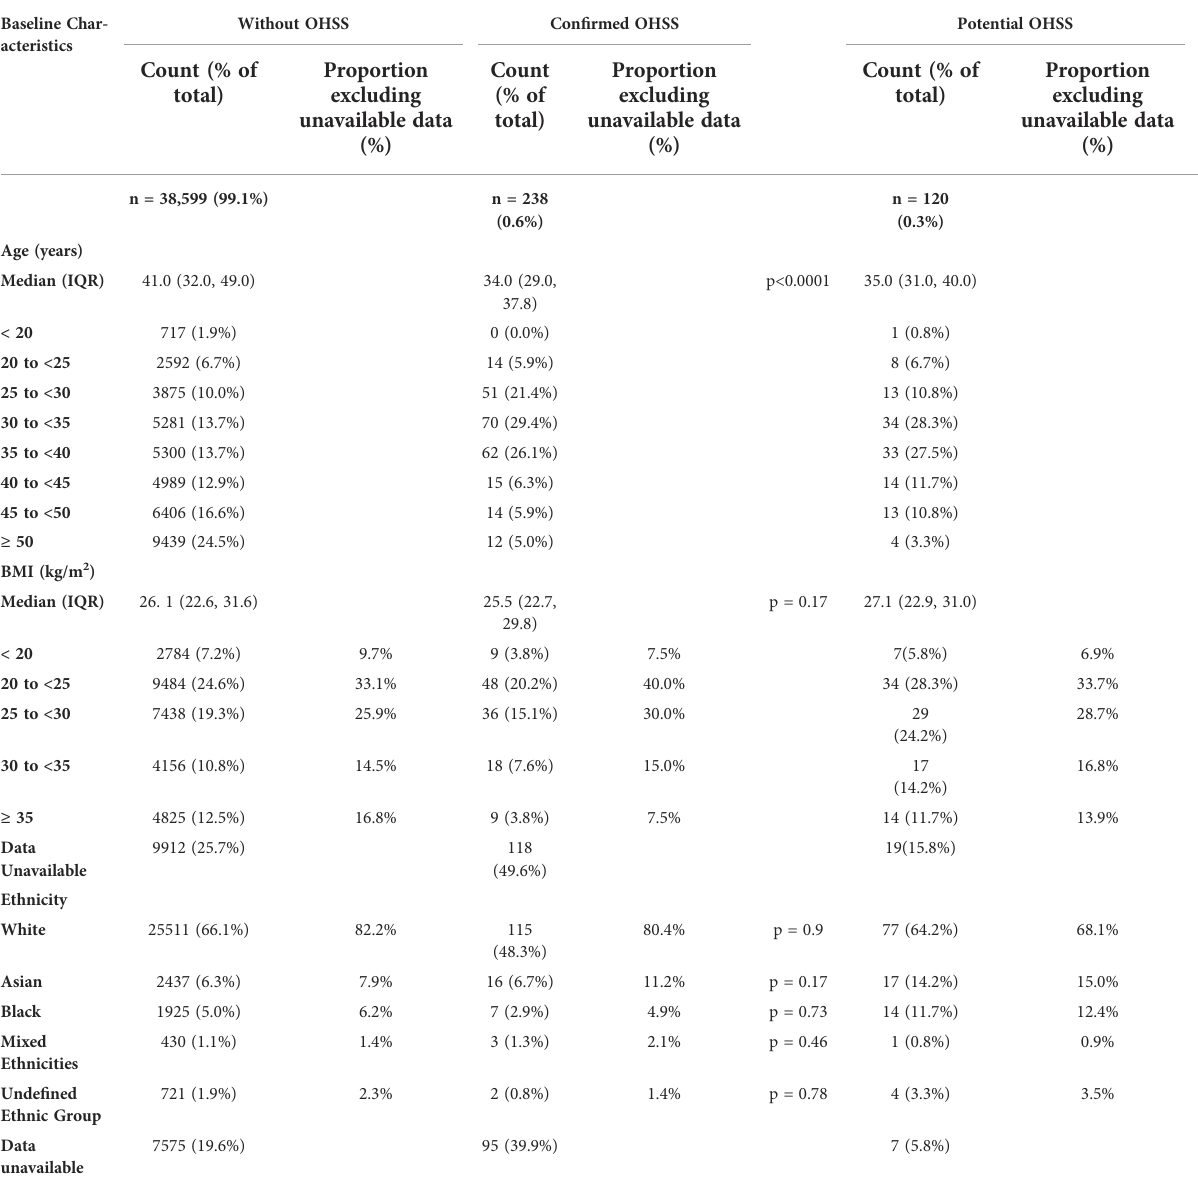
TABLE 1 Demographic characteristics of patient data retrieved from ICNARC,